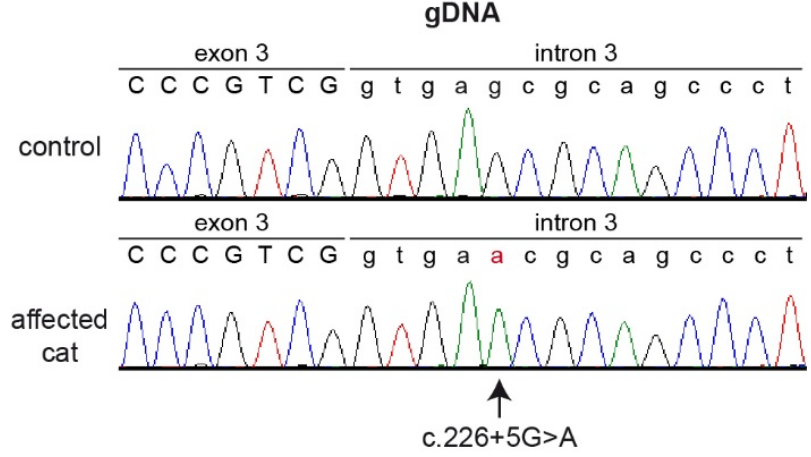
Figure 2. Sanger sequencing electropherograms of the affected and a control cat illustrating the single nucleotide exchange at the beginning of intron 3. The variant position is indicated by an arrow. The altered base is indicated in red.